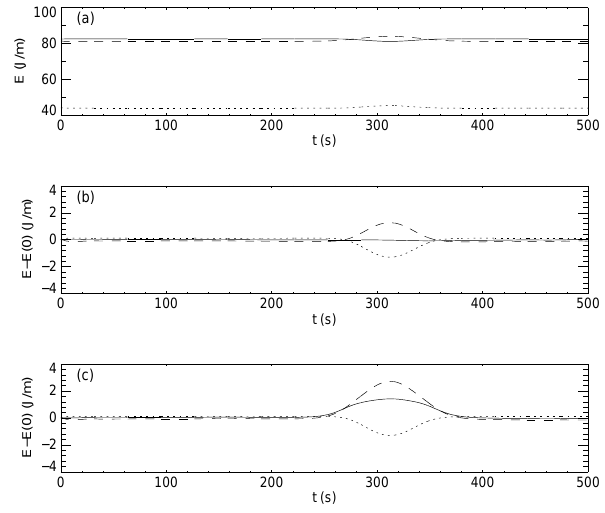
Fig. 5. Energetics for ISW interaction. (a) Solid curve: ¯ E a . Dots: ¯ E ¯ E kp . Dashed: k2 . (b) Dashed: Solid curve: their sum. (c) Dashed: ¯ E k2 − ¯ E k2 ( 0 ) . Dots: ¯ E a − ¯ E a ( 0 ) . Solid curve: their sum.